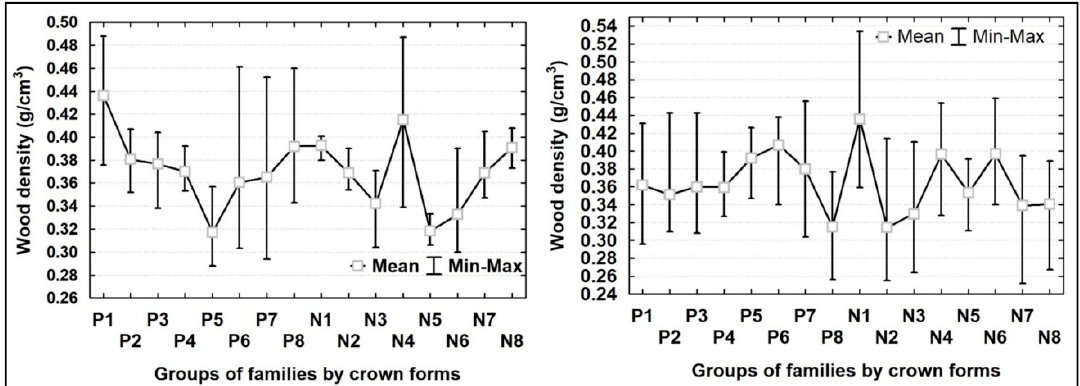
Figure 5. Conventional wood density in the M ă neciu ( left ) and Soveja ( right ) trials.